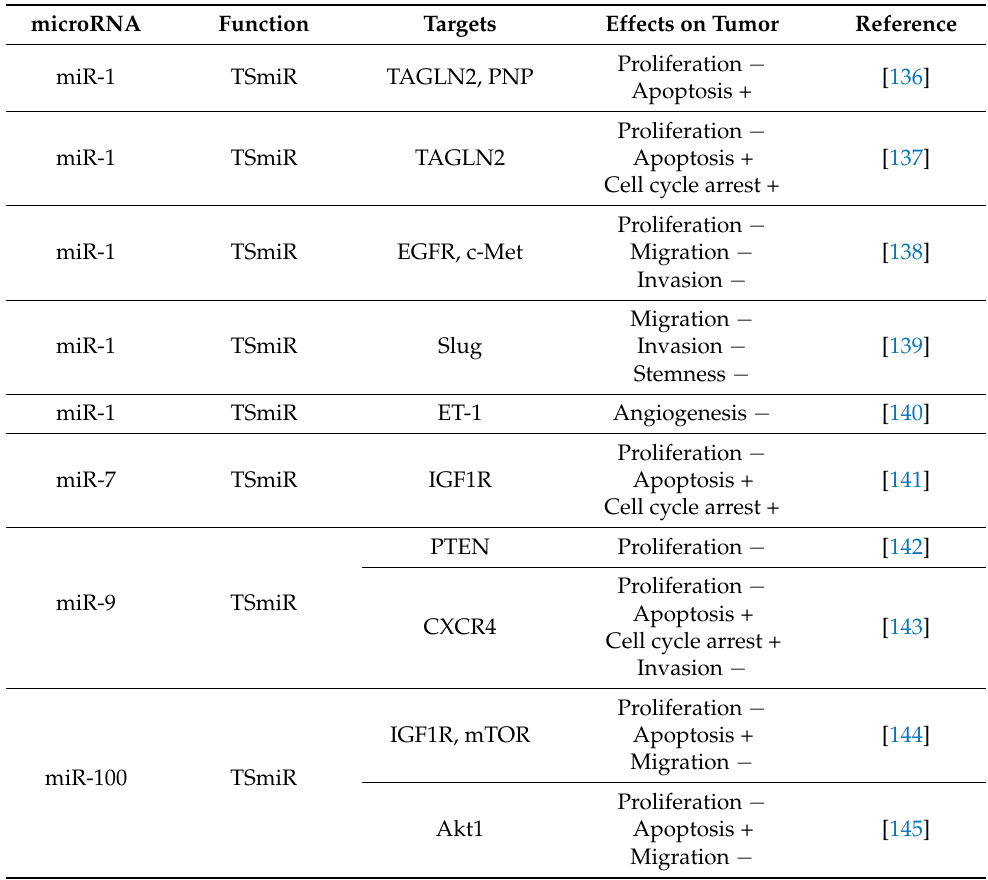
Table 2. Aberrant microRNA in